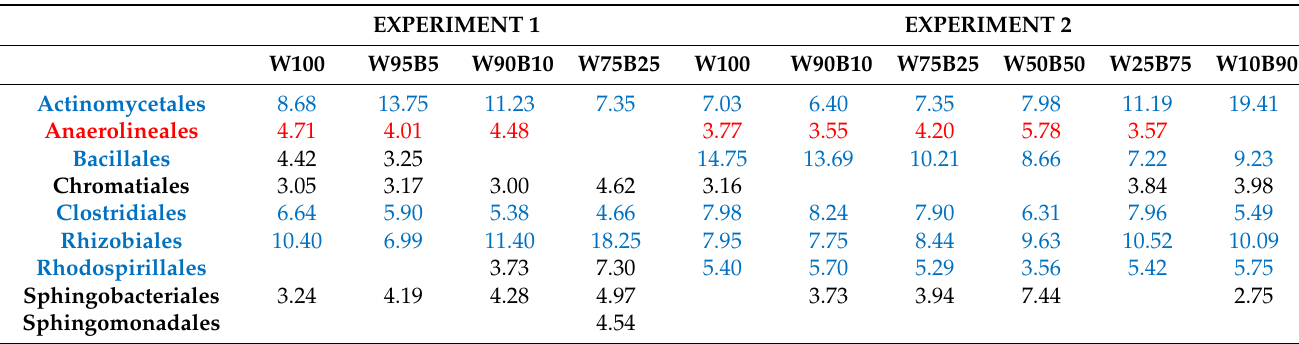
Table 2. Order classification for worm castings (W) blended with biochar (B) by percent of total nucleic acids in the sample metagenome.